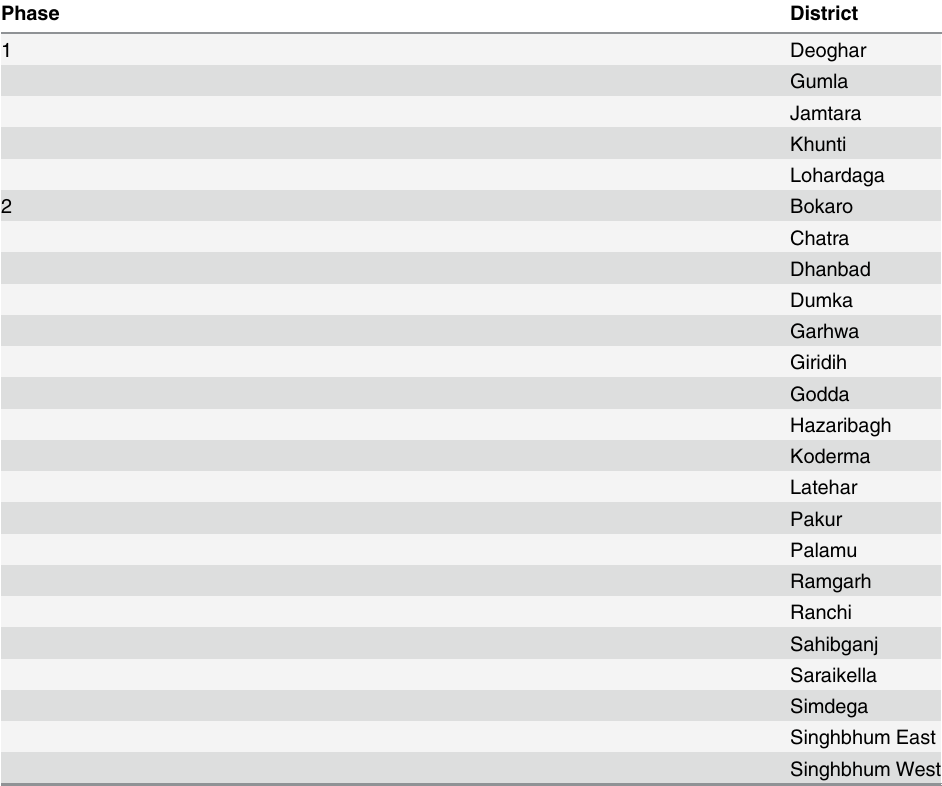
Table 1. Districts covered in phase 1 and 2 measles vaccination campaigns, Jharkhand, 2010 –